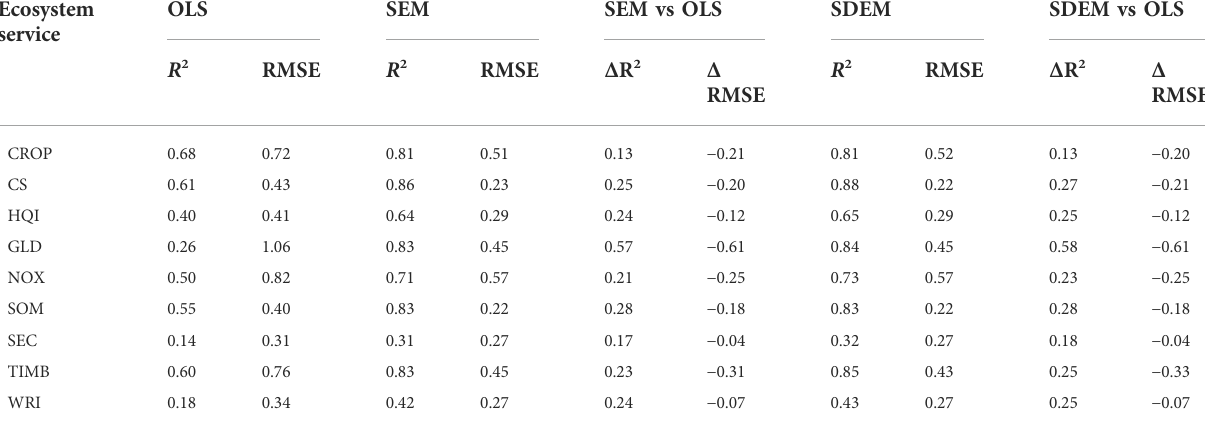
TABLE 4 Goodness-of- fi t ( R 2 ) and prediction quality (RMSE) of the models (columns) per ecosystem service (rows). The models shown are a non- spatial model (OLS), the spatial error model (SEM), and the spatial Durbin error model (SDEM) as they showed the best performances with the Lagrange Multiplier test. We also show the difference in goodness-of- fi t and prediction quality between the OLS model and spatial models ( Δ R 2 and Δ RMSE ).CROPstandsforcropproduction;CSforcarbonstorage;HQIforhabitatqualityindex;GLDforgrazinglivestockdensity;NOXfordeposition velocity of nitrous oxide; SOM for topsoil organic matter concentration; SEC for soil erosion control; TIMB for timber removal; WRI for water retention index. We found that compared to OLS, R 2, and RMSE improved for all the spatial models. Ecosystem